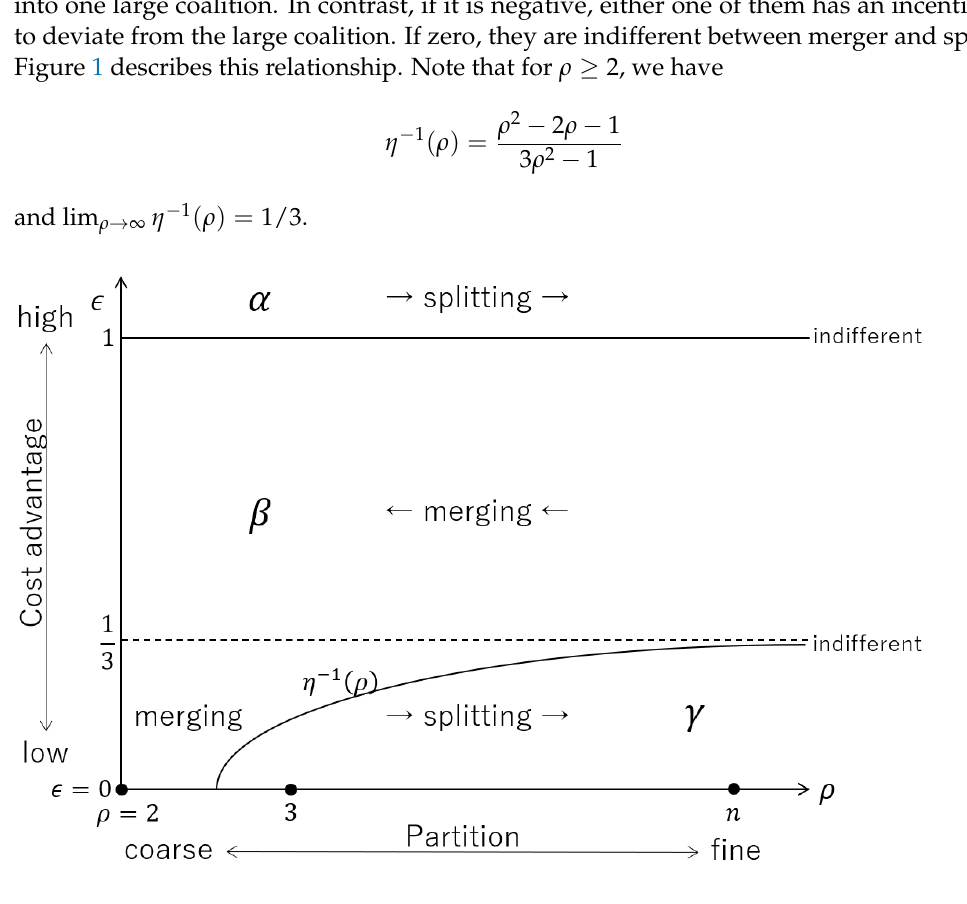
Figure 1. Cost advantage and tendency of coalition